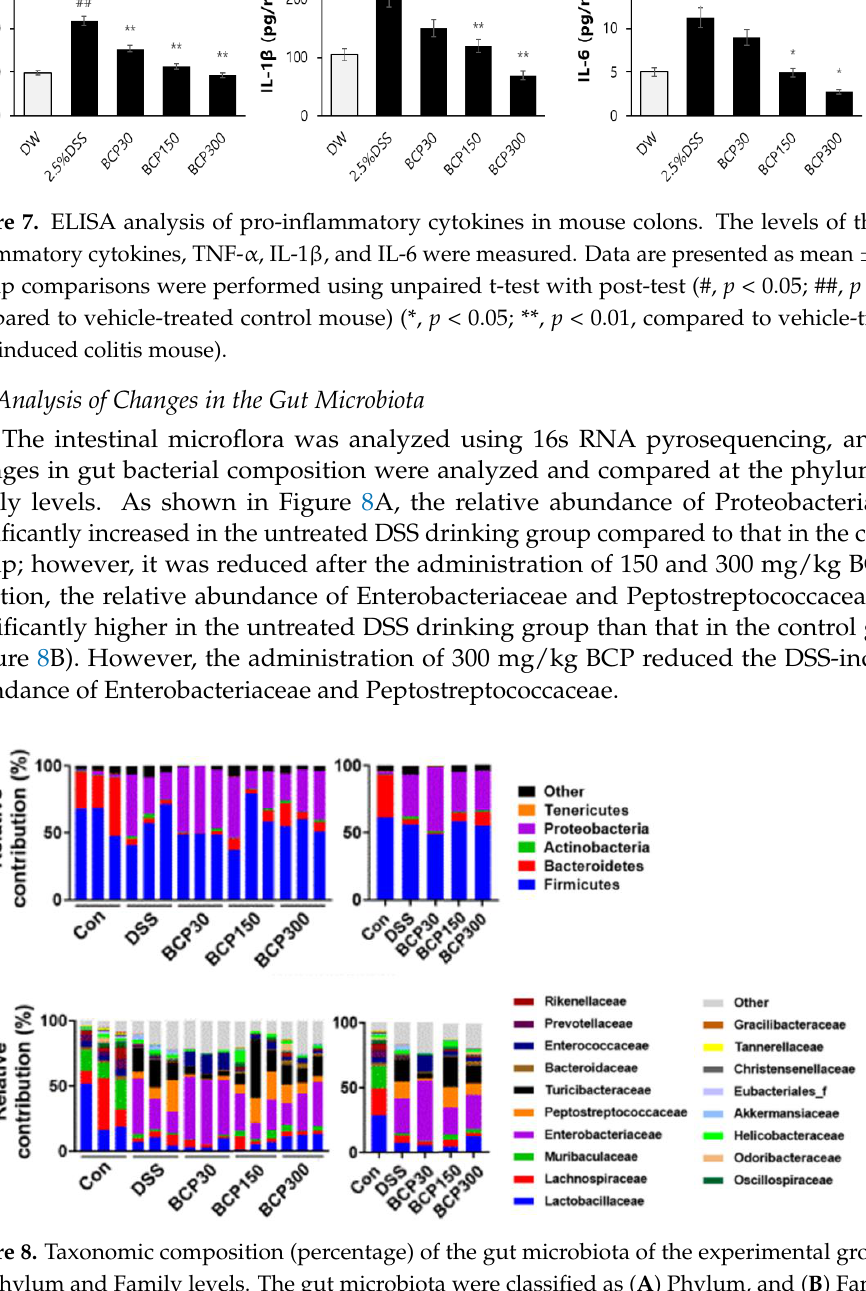
Figure 6. The activity of myeloperoxidase (MPO) in mouse colons. MPO activity in the colon was measured as an immunological parameter for acute inflammation. Data are presented as mean ± SEM. Group comparisons were performed using unpaired t-test with post-test (##, p < 0.01, com- pared to vehicle-treated control mouse) (*, p < 0.05; **, p < 0.01, compared to vehicle-treated, DSS- induced colitis mouse).